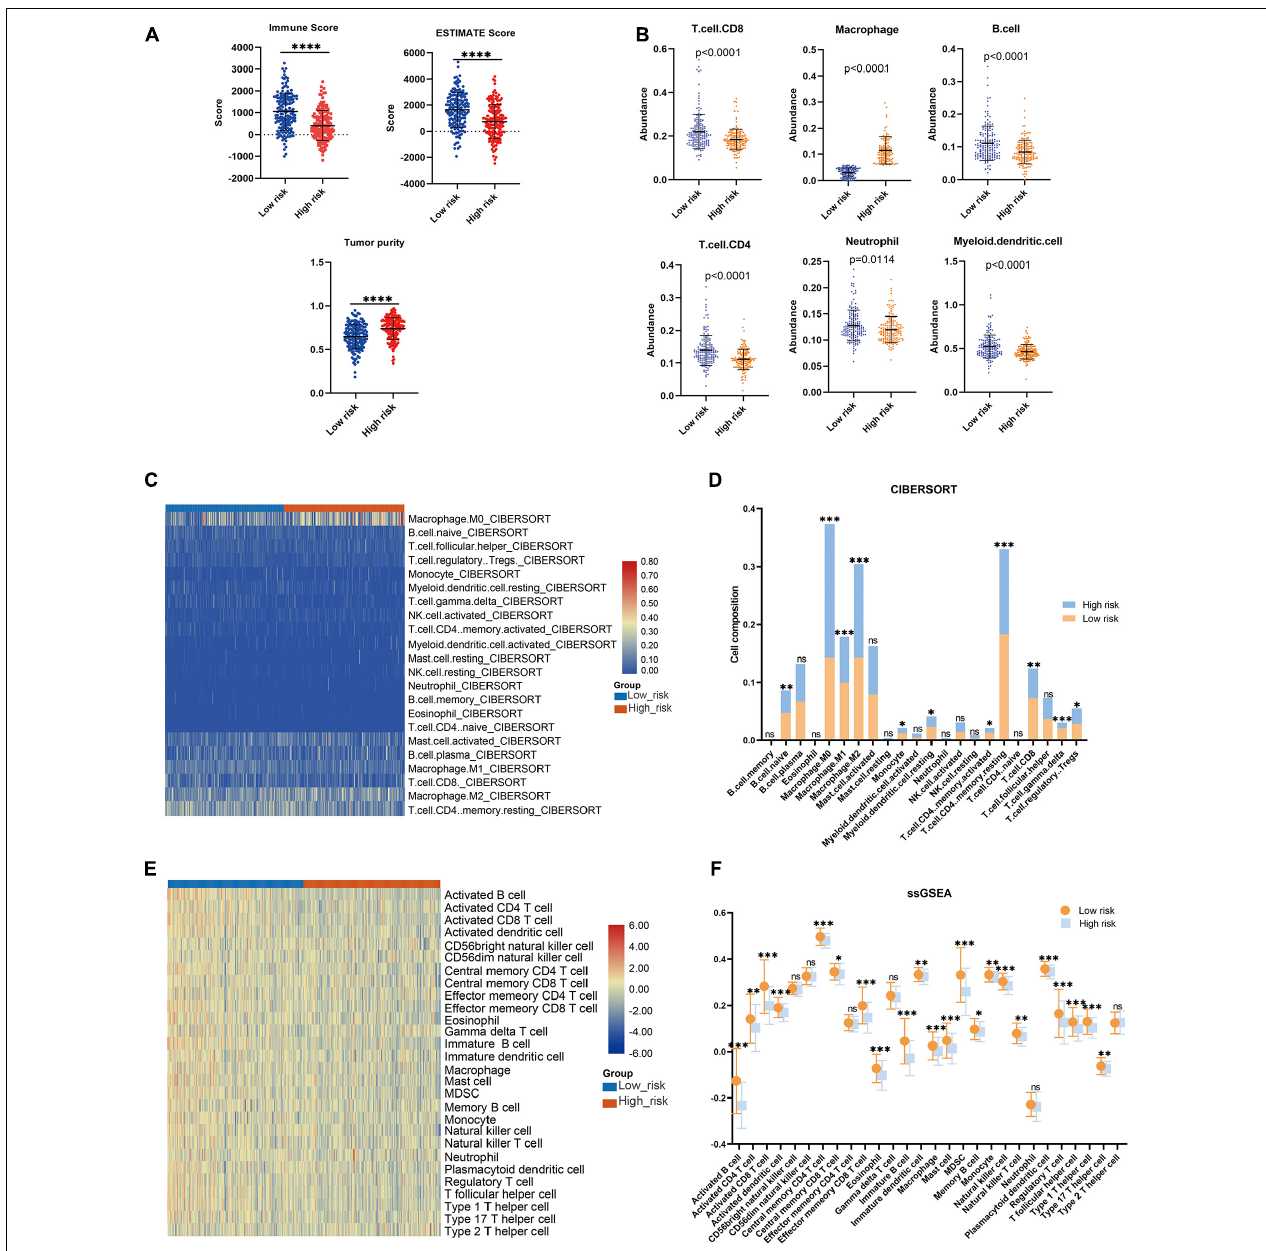
FIGURE 7 | Association between the risk model and immune microenvironment in the validation cohort. (A) ESTIMATE algorithm, (B) TIMER algorithm, (C,D) CIBERSORT analysis, and ssGSEA analysis (E,F) . * p < 0.05, ** p < 0.01, *** p < 0.001, **** p <